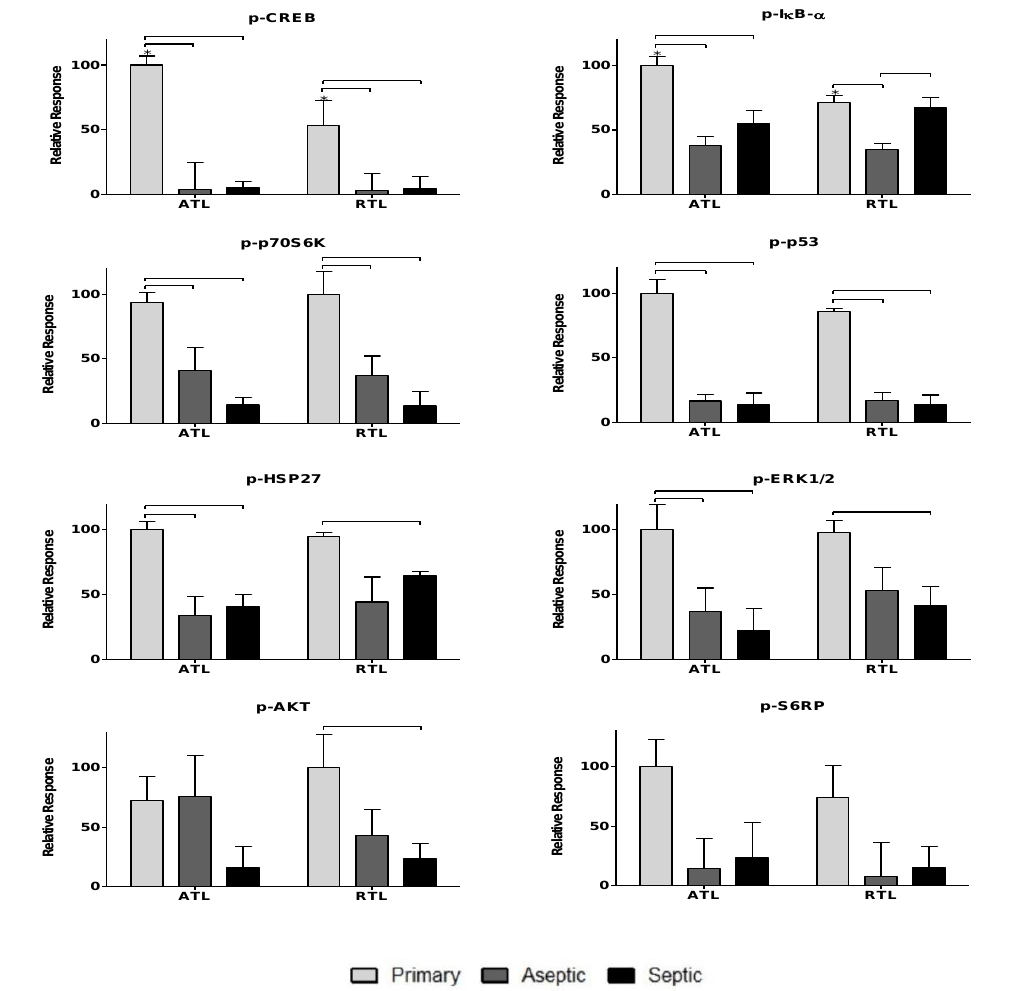
Figure 3. Relative levels of phosphoproteins associated with the proliferative processes in acute wound healing. Relative phosphoprotein responses (normalized to highest signal) were observed for all three patient groups: primary, aseptic, and septic at two debridement depths: ATL is closer to the knee joint, and RTL is approximately 1 cm removed from the knee joint. Statistically significant differences ( p < 0.05) were determined by two-way ANOVA with Bonferroni’s post-test to examine group-dependent and spatially-dependent differences in protein phosphorylation. Differences for the same group (i.e., septic) between ATL and RTL are marked with an asterisk (*). Differences between groups within a tissue layer are denoted with bars. Responses are shown as the mean ± SEM.